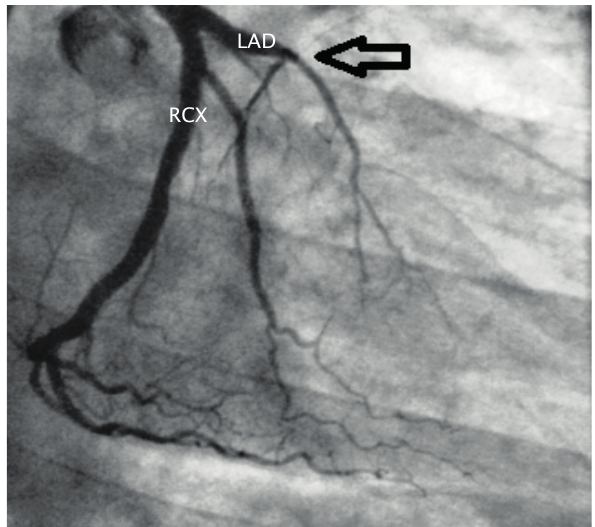
Fig. 2. Total thrombotic occlusion of proximal segment of left anterior descending coronary artery (see arrow). LAD; left anterior descending coronary artery, RCX; circumflex artery urea nitrogen and serum creatinine. Serum minerals